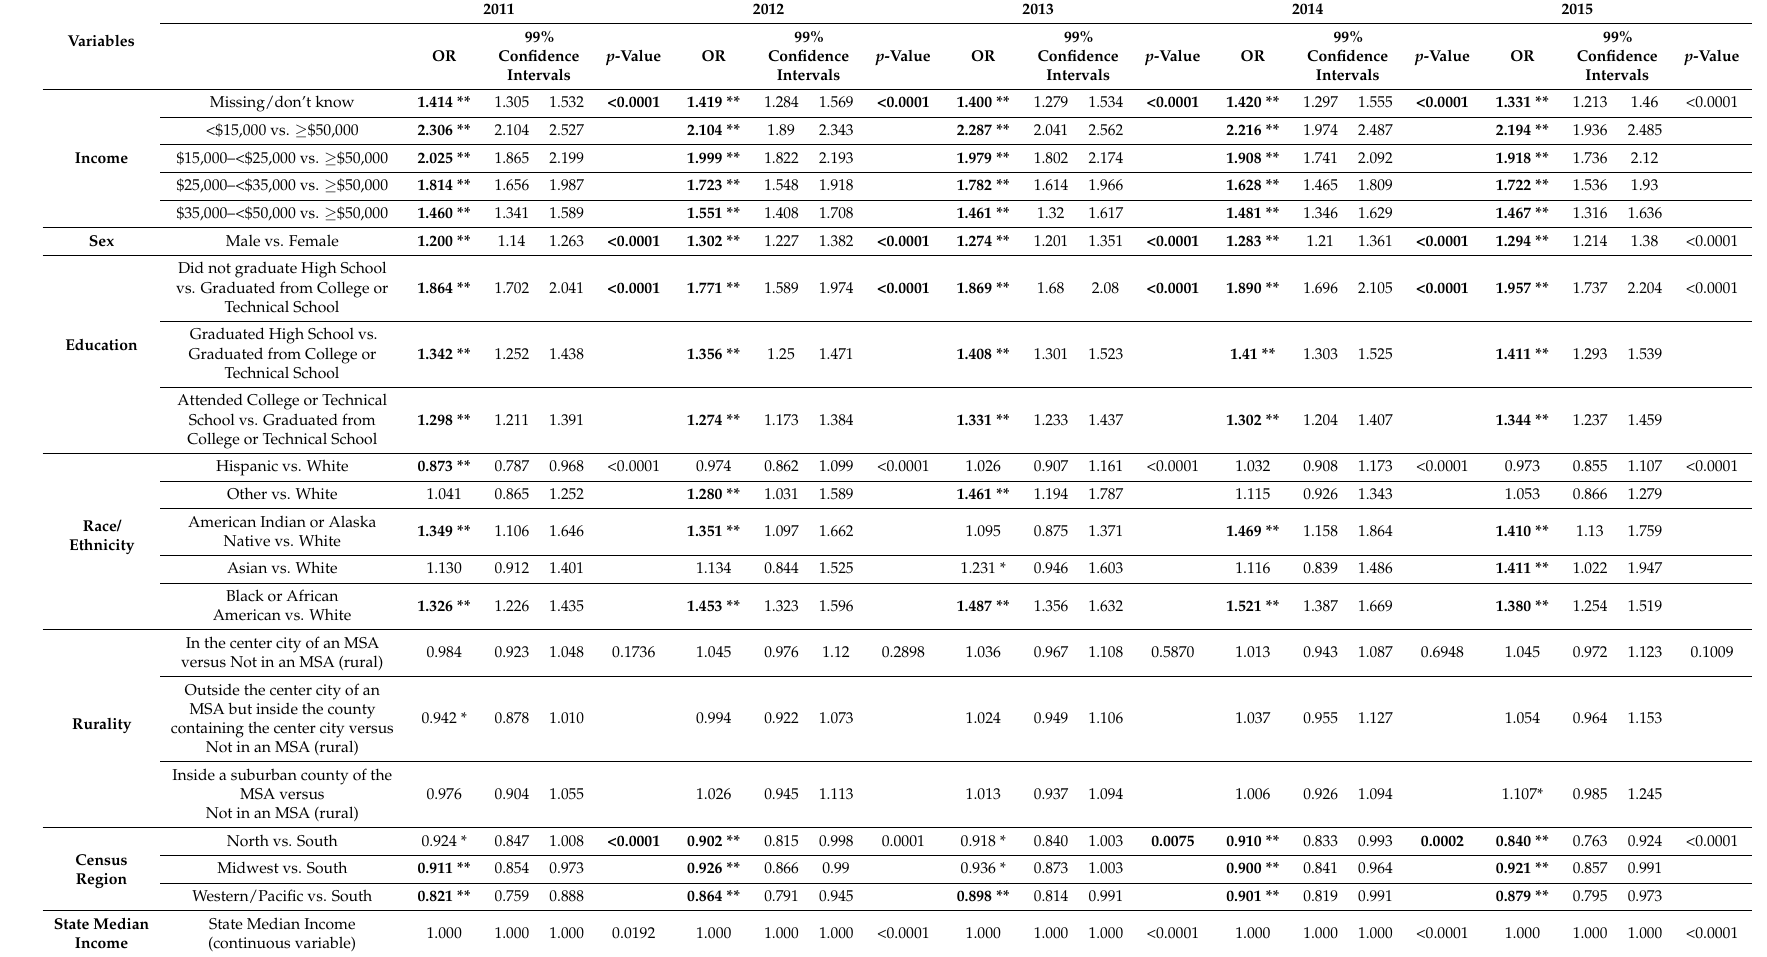
Table 3. Adjusted analysis for diagnosed